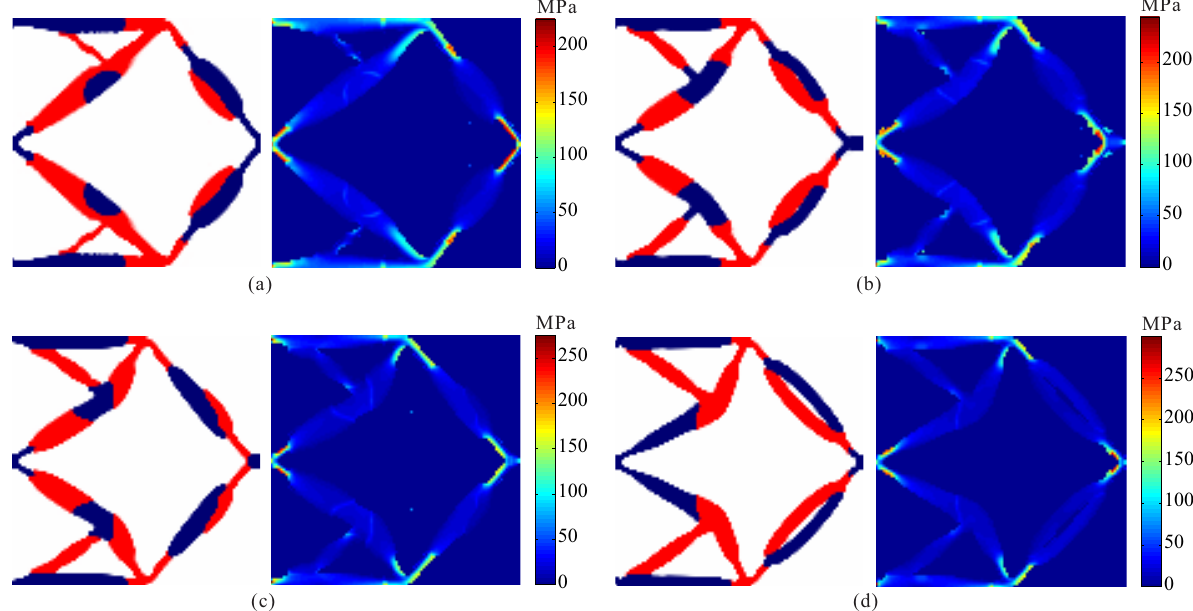
Figure 5. The results for topological design of multi-material compliant inverter under different stress constraint limits. ( a ) σ ∗ = 150 MPa, σ ∗ = 225 MPa; ( b ) σ ∗ = 175 MPa, σ ∗ = 250 MPa; ( c ) σ ∗ = 200 MPa, σ ∗ = 275 MPa; ( d ) σ ∗ = 225 MPa, 2 2 2 1 1 1 1 σ ∗ = 300 2